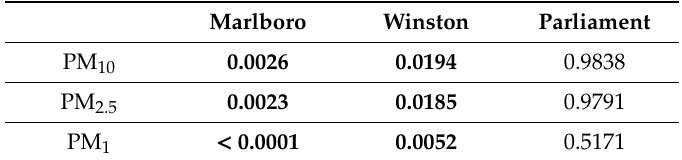
Figure 1. Comparative boxplot (min to max whiskers) of the area under the curve (AUC) PM 1 of country-specific brands. The results are based on a statistical two-way analysis of variance (ANOVA) test. UAE = United Arab Emirates. GER = Germany. Table 3. p -values of statistical Sidak’s multiple comparisons test of C mean (PM 10 , PM 2.5 , PM 1 ) for the three cigarette brand pairs from the UAE and